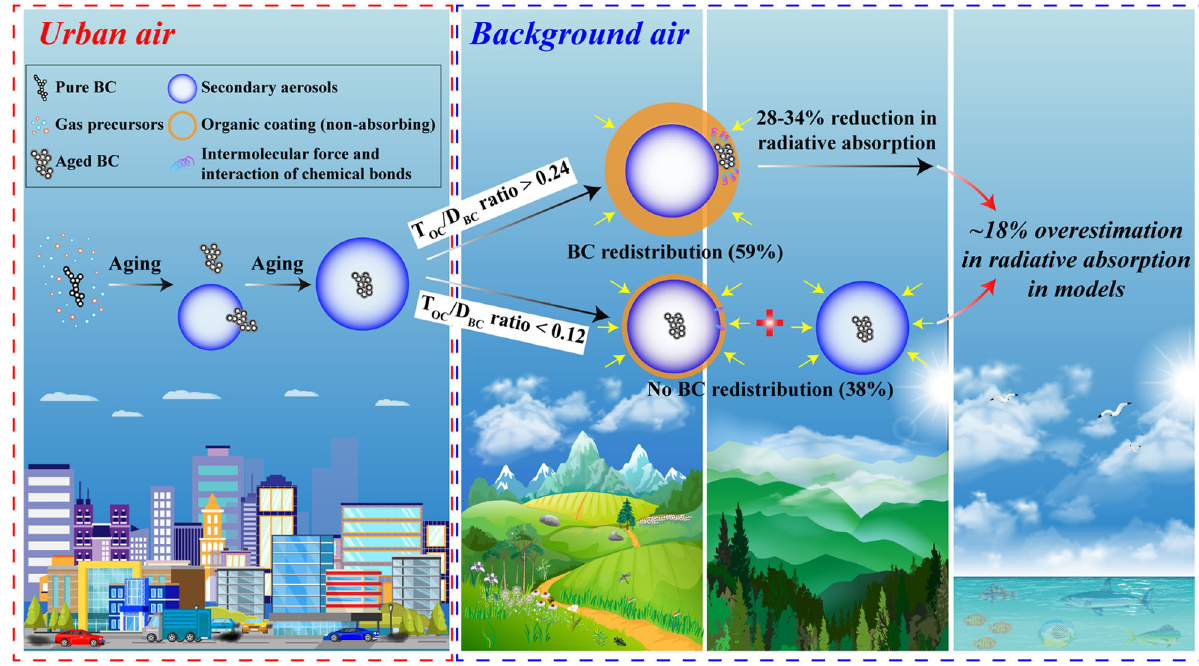
Fig. 6 A schematic diagram of BC redistribution and change in the optical absorption of BC following particle aging and transport. The T OC /D BC ratio determines whether BC particles can be redistributed into organic coatings from inorganic salt cores. When the organic coating is non-absorbing, the light absorption of internally mixed particles containing one and two BC reduces by 28-34% following the BC redistribution. Further, the radiative absorption of BC in the background air is overestimated by ~18% in most models that assume internally mixed BC aerosols to be the core-shell